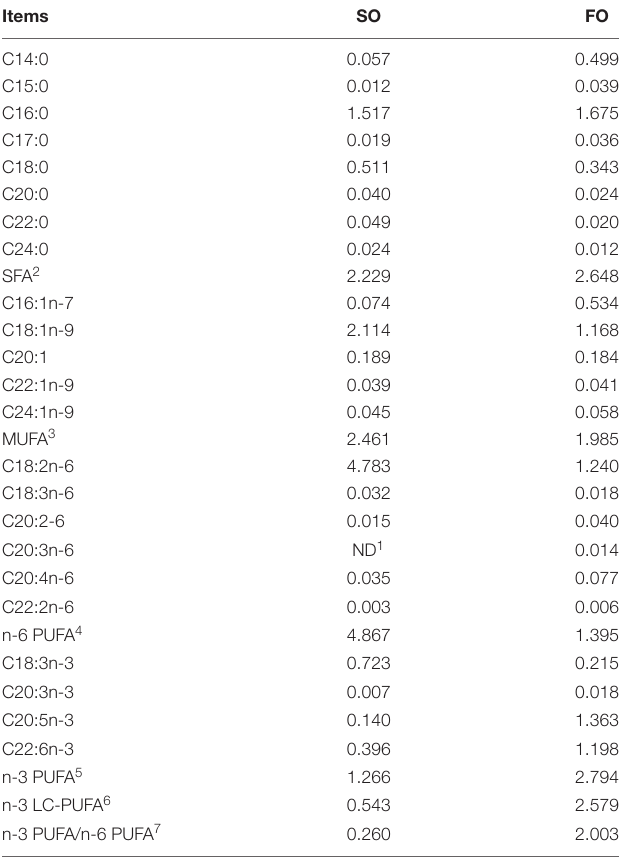
TABLE 2 | Fatty acid composition of the experimental diets (g/100 g). Items SO